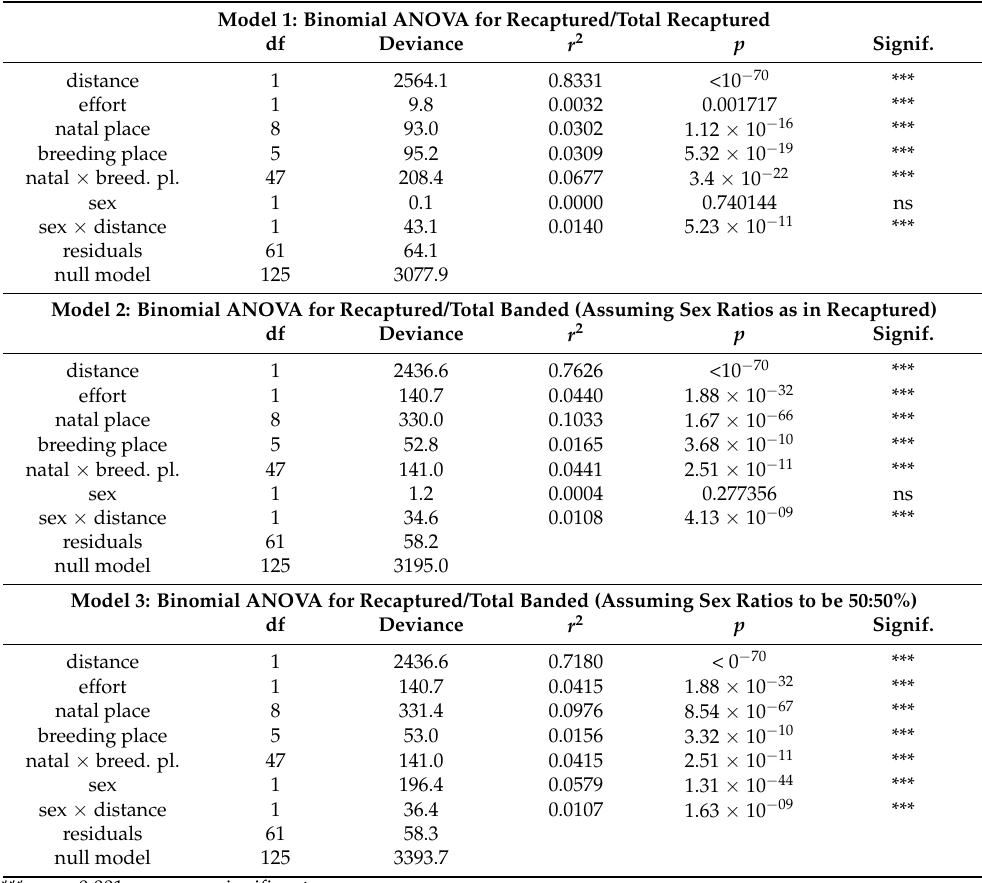
Table 2. Analysis of deviance (binomial-error ANOVA) for recovered bands under three different model hypotheses (see Methods section for